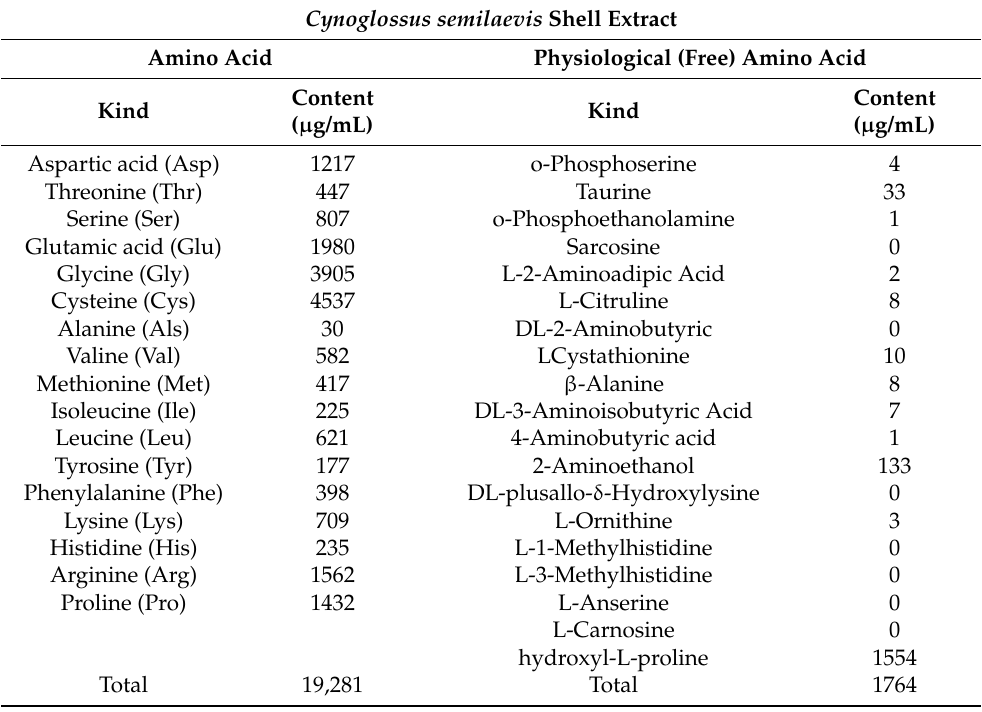
Table 1. Amino acid composition in Cynoglossus semilaevis shell extract (please see the attachment). Cynoglossus semilaevis Shell Extract Amino Acid Physiological (Free) Amino